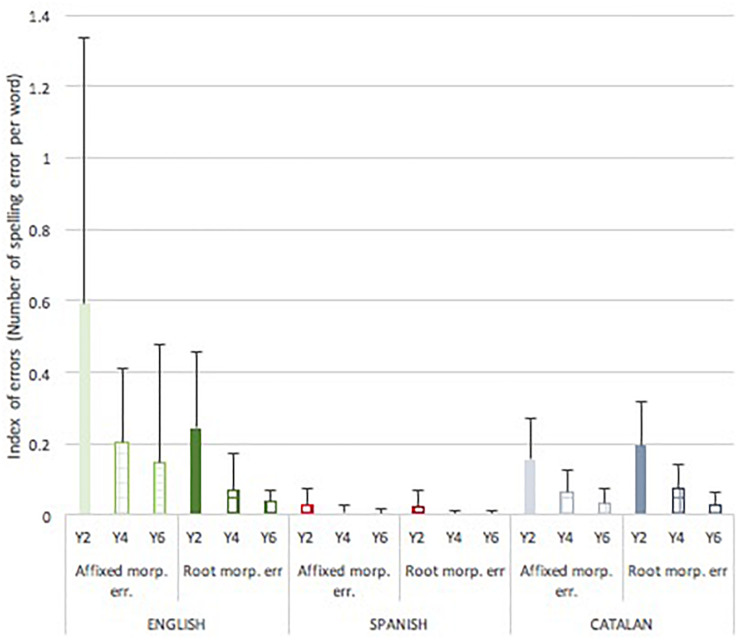
Mean (SD) index of spelling number of spelling errors at the root level per word and at the morpheme level per morphologically complex word by language and school grade.